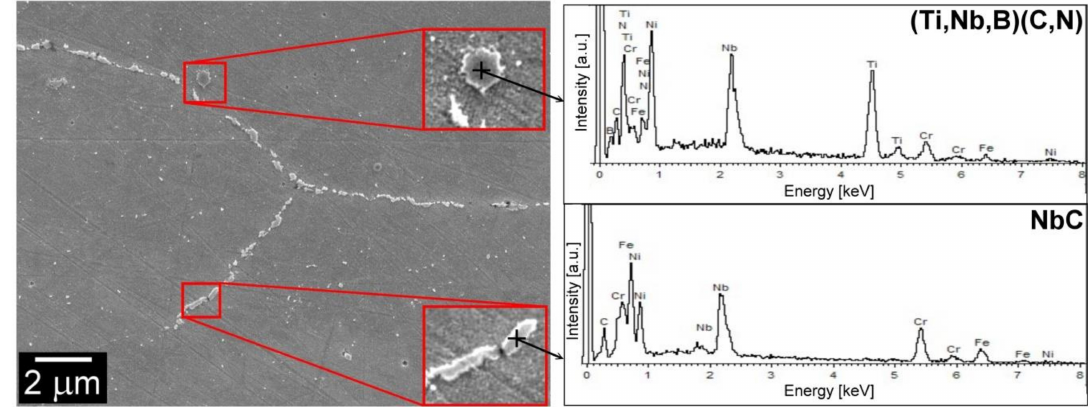
Figure 6. SEM-micrograph of Ni-based weld metal (Ni WM) region Thermanit Nicro 82 of the investigated T92/TP316H dissimilar weldment in “QT PWHT” condition and typical EDX-spectra from spot-EDX analyses of primary (Ti,Nb,B)(C,N) and secondary NbC precipitate